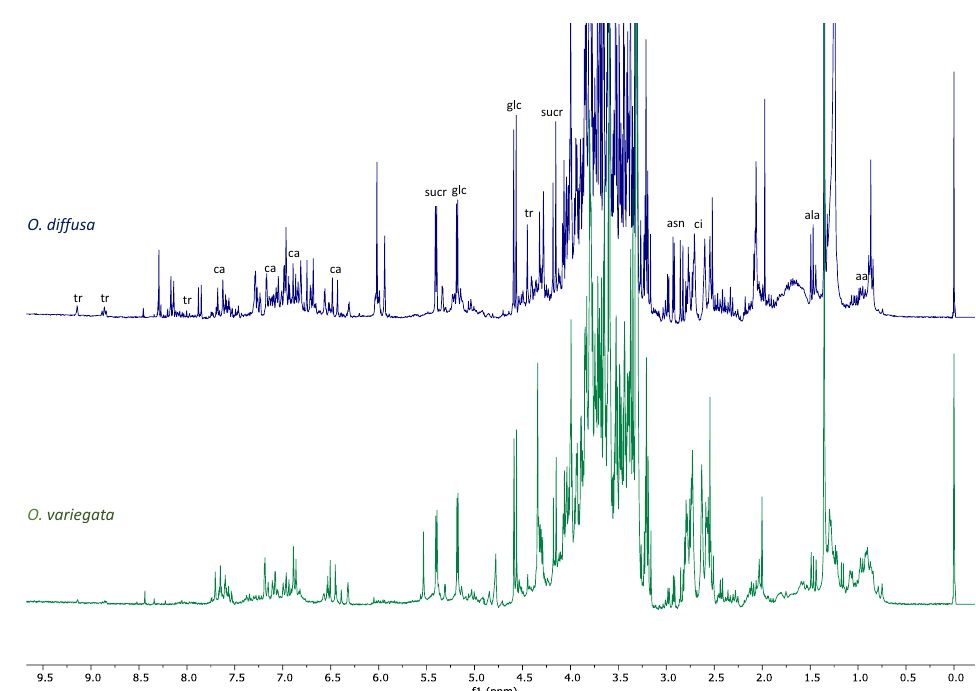
Figure 3. Stacked 1 H-NMR spectra of O. variegata (green) and O. diffusa (blue). Spectra were acquired at 300 MHz, in 1:1 methanol- d 4 : buffer. Diagnostic signals of the main metabolites detected in both extracts are indicated on O. variegata spectrum by the following abbreviations: aa = amino acids, ala = alanine, asn = asparagine, ca = caffeic acid, ci = citric acid, glc = glucose, sucr = sucrose, tr = trigonelline.